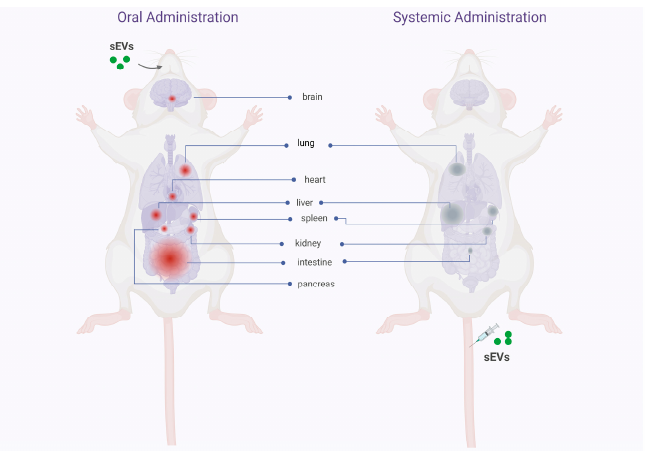
Figure 3. Comparative diagram of the biodistribution pattern of sEV administered orally and intravenously. The illustration shows the pattern of biodistribution of sEVs in different mice tissues after oral or intravenous administration. In the body on the left, the tissues and organs where the sEV would accumulate after intestinal absorption are identified in red. The considerable accumulation of sEVs in the intestine and, to a lesser extent, in the rest of the body’s organs stands out. In the body on the right, the organs where sEVs would accumulate after intravenous administration are identified in gray. A considerable accumulation of sEVs is observed in the organs associated with the mononuclear phagocytic system (liver, spleen, lung), with little reach to other body organs. These data suggest that the biodistribution pattern is defined by the route of administration of the sEVs, a dependency that can be used strategically to reach a specific organ in patients (created with http://www.biorender.com (accessed on 2 february